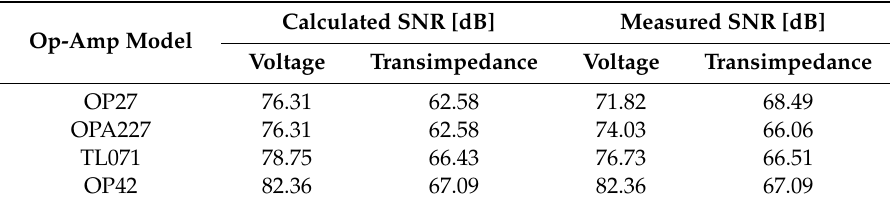
Table 3. Comparison of theoretical and measured SNRs for preamplifiers implemented with di ff erent operational amplifier models working in transimpedance and voltage